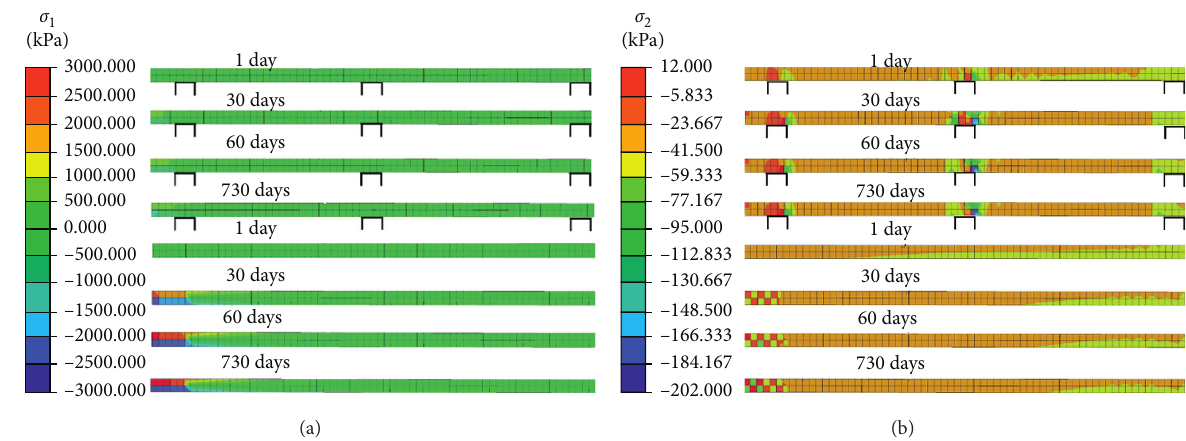
Figure 10: Pile (20m) simulation results.